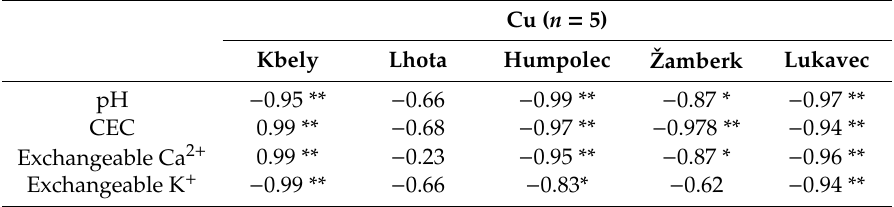
Figure 2. Effect of biochar addition on soil-available content of Cu (mg kg − 1 ). On the horizontal axis, 1 and 12 stand for 1st and 12th week of incubation period or sample collection time, respectively. Di ff erent capital case letters represent significance di ff erence ( p < 0.05) of treatments within same sample collection time of same soil. Table 5. Pearson correlation coe ffi cient of available Cu content with soil pH, CEC, and exchangeable Ca 2 + and K + after addition of four levels of biochar (0.5%, 2%, 4% and 8%) at the 12th week of